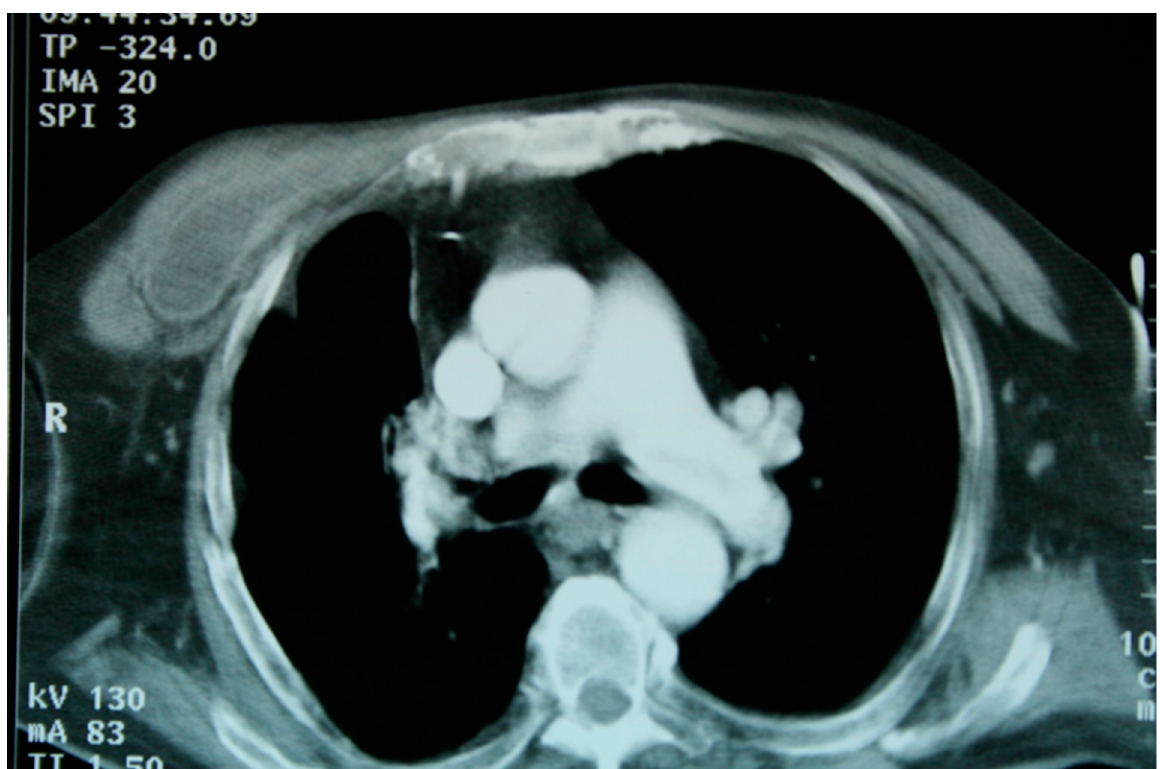
Figure 8. Intraoperative images of patient 2 with pulmonary echinococcosis. An energy device per- forms dissection without rupture of a large intraparenchymal cyst.